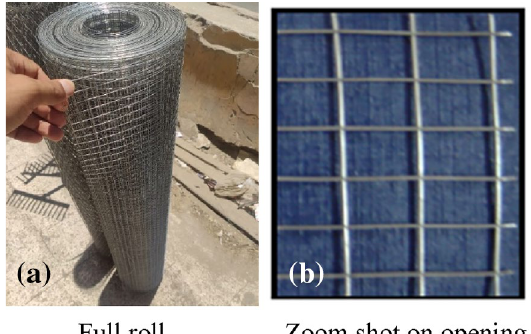
Fig. 6 Welded wire mesh